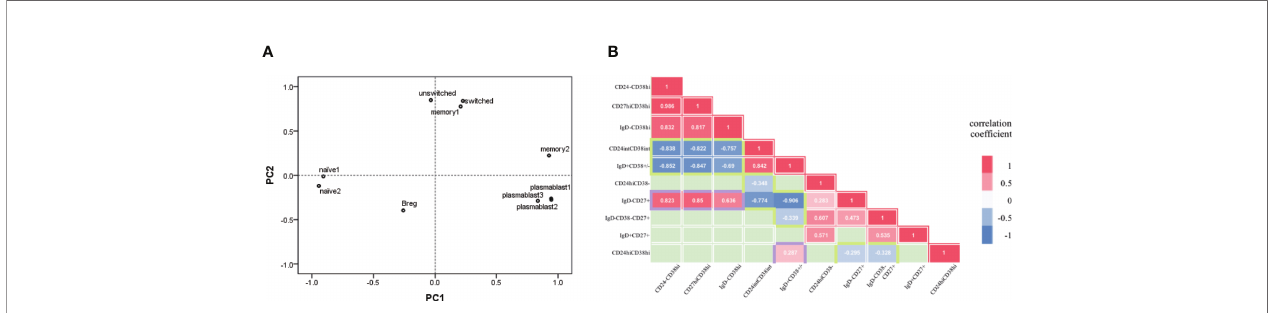
FIGURE 3 | B-cell subsets in active IgG4-RD patients presented plasmablast-naive B- cell and MBCs-Breg axes abnormalities. (A) Each B-cell subset immunophenotype was visualized in 2 two dimensions by principal components (PC) analysis. plasmablast1, CD19+CD24-CD38hi; plasmablast2, CD19+CD27hiCD38hi; plasmablast3, CD19+IgD-CD38hi; naïve1, CD19+CD24intCD38int; naïve2, CD19+IgD+CD38±; memory1, CD19+CD24+CD38-; memory2, CD19+IgD-CD27+; switched, CD19+IgD-CD38-CD27+ switched memory B cell; unswitched, CD19+IgD+CD27+ unswitched memory B cell; Breg, CD19+CD24hiCD38hi. (B) Correlation between pairs of B-cell types (10 immunological types). Correlation coef fi cients for each pair of cell types are represented by colour [red=positive correlation coef fi cient (p<0.05); blue=negative correlation coef fi cient (p<0.05); green=no signi fi cant